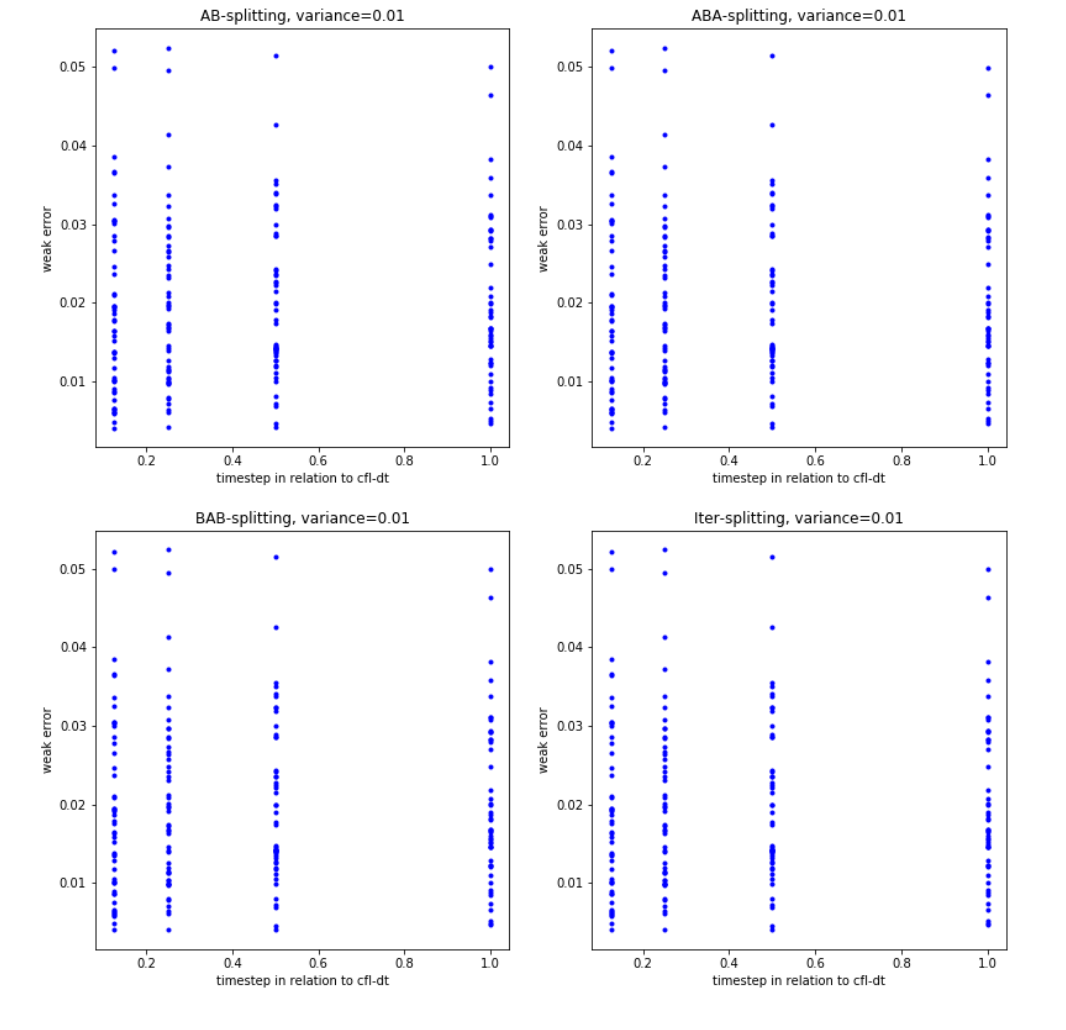
Figure 3. For the experiments, we have applied the L 1 -error given in Equation (73). For the variance of the W ( t ) stochastic process, we used E 2 ( ∆ W ) = 0.01. We applied 10–00 runs for the error evaluation. In the left-hand upper panel, we present the L 1-errors of the AB-spitting approach with different time-steps. We obtain smaller errors for more runs. In the right-hand upper panel, we present the L 1-errors of the ABA-spitting approach with different time-steps. We obtain smaller errors for more runs. In the left-hand lower panel, we present the L 1-errors of the BAB-spitting approach with different time-steps. We obtain smaller errors for more runs. In the right-hand lower panel, we present the L 1-errors of the iterative-spitting approach with different time-steps. We obtain smaller errors for more runs and improved the